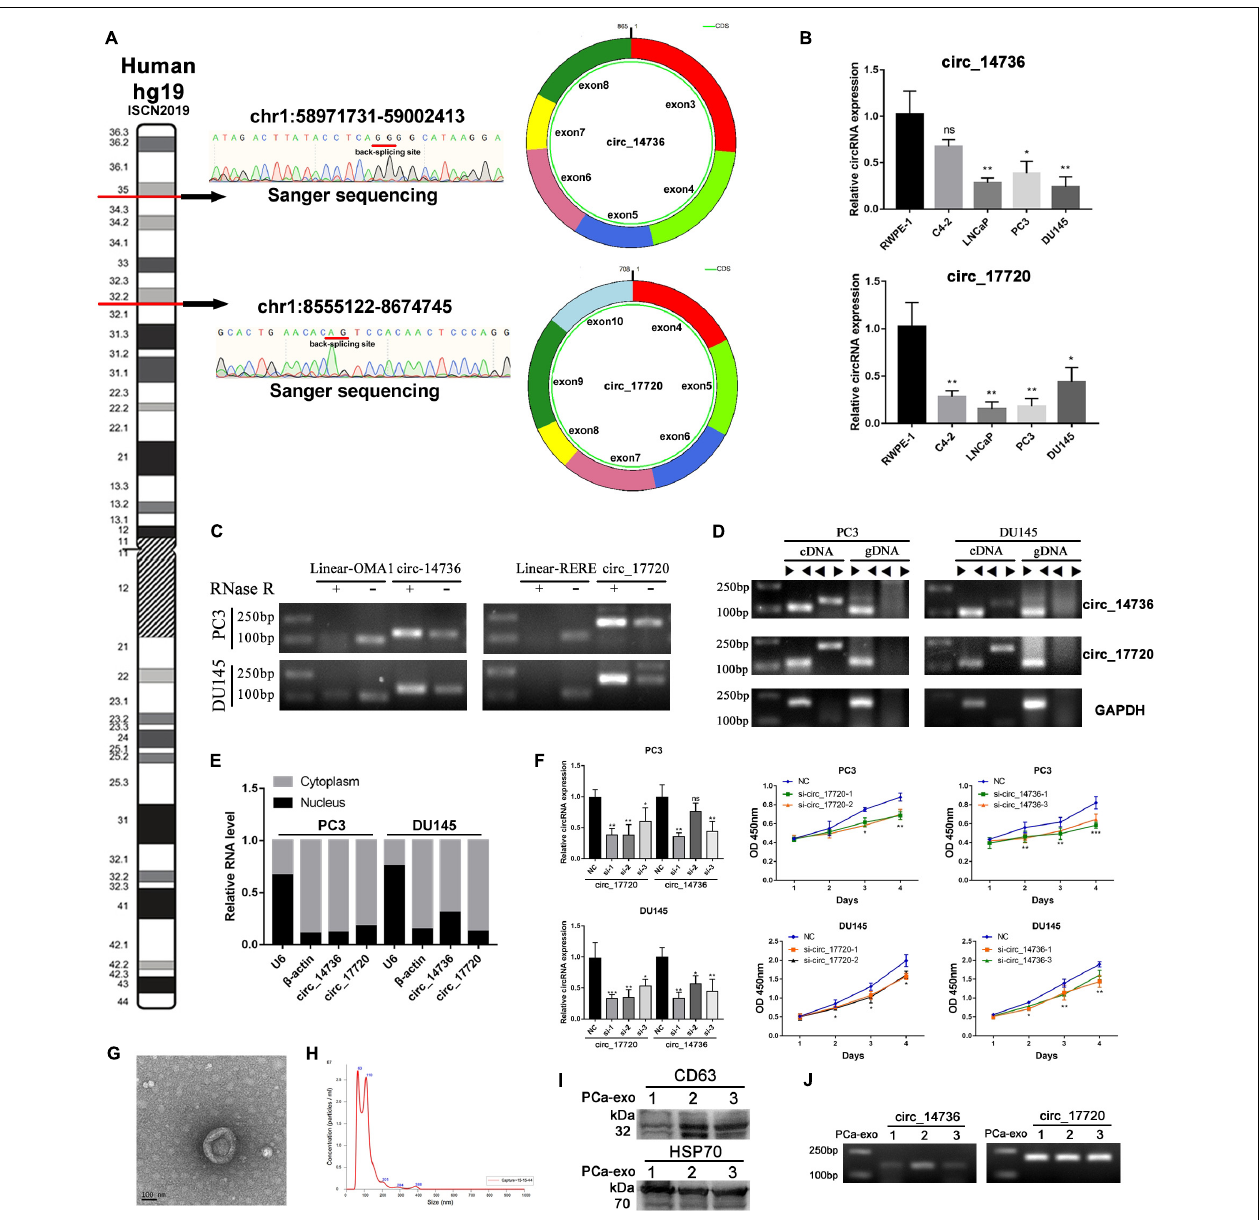
FIGURE 6 | Experimental validation of circ_14736 and circ_17720. (A) The back-splicing junction site of circ_14734 and circ_17720 was determined by sanger sequencing. (B) The naive expression of circ_14734 and circ_17720 in prostate cancer cell lines. (C) circ_14734 and circ_17720 could be detected after the treatment of RNase R digestion. (D) the amplification of circ_14734 and circ_17720 by convergent and divergent primers was examined in cDNA and gDNA. (E) The distribution of circ_14734 and circ_17720 by nuclear and cytoplasmic fraction was determined by RT-qPCR. (F) Si-RNAs knock down effect screening. circ_14734 and circ_17720 inhibited DU145 and PC3 cell proliferation via CCK-8 assay. (G,H) The morphology and particle size distribution of Plasma-derived exosomes were verified by TEM and Nano-Sight. (I) Western blot analysis of exosomes isolated from three PCa patients’ blood plasma. The exosomal markers CD63 and HSP70 were detected. J. circ_14734 and circ_17720 were examined in blood plasma exosomes by gel